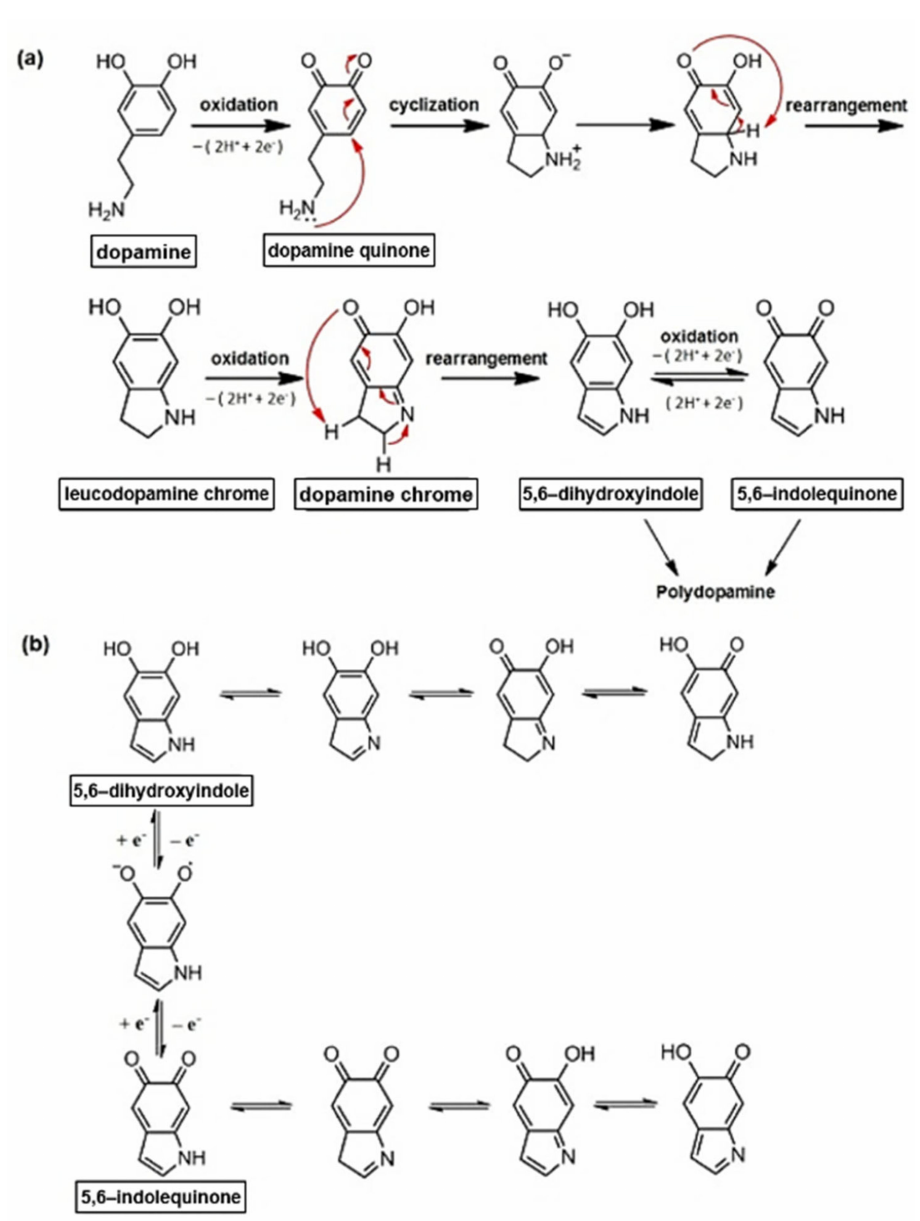
Figure A1. ( a ) Proposed reaction mechanism for polydopamine and ( b ) intermediate species and tautomers of intermediate species (5,6-hydroxyindole and